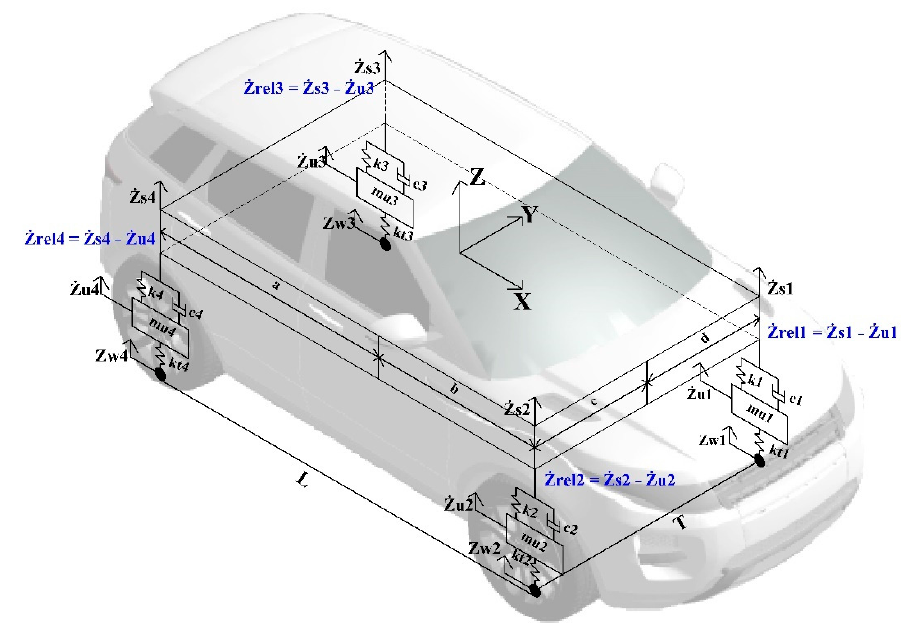
Figure 1. SUV dynamic model. Table 1. Data used in mathematical